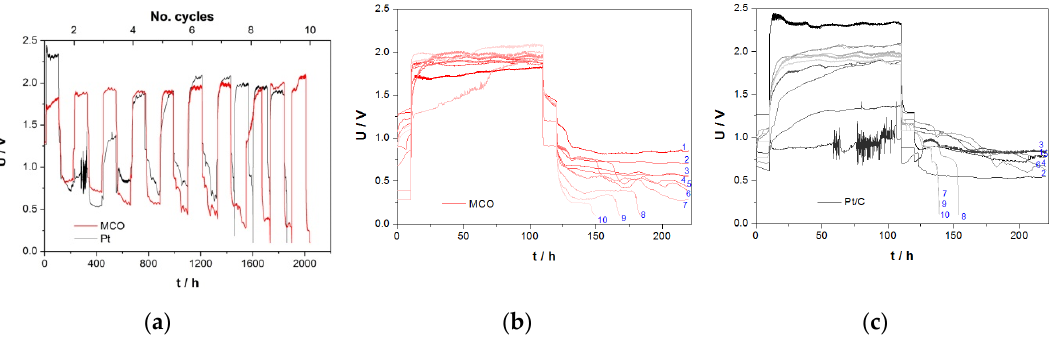
Figure 14. ( a ) Long-term stability cycling test of MCO and Pt cells in ChAcO + 0.01 M ZnAcO 2 + 30 wt.% H 2 O cell at 100 µA cm − 2 for about 10 days/cycle in ambient air (30% RH at 23 °C). ( b , c )